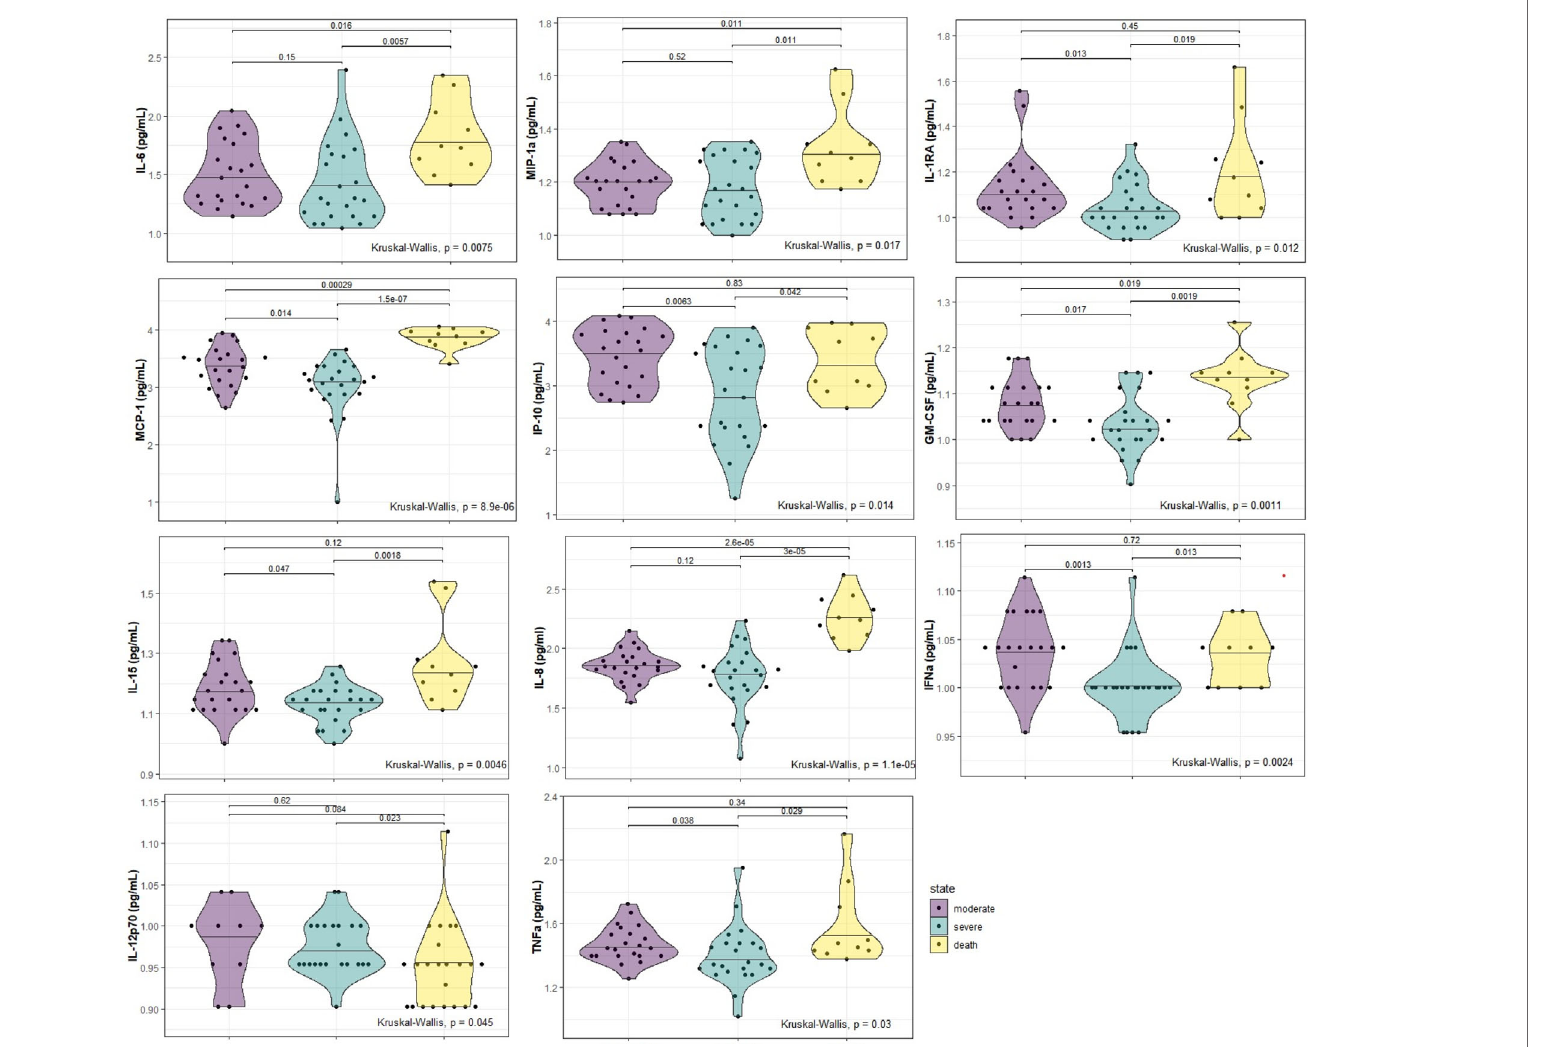
FIGURE 2 | Serum biomarkers with signi fi cant differences in the three study groups (moderate, severe and deceased) of hospitalized COVID-19 patients at baseline. P-values were computed by the Kruskal-Wallis test and a post-hoc analysis by Dunn ’ s